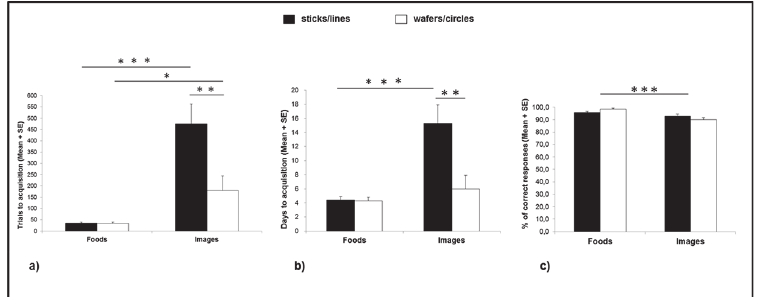
Fig 3. Monkeys ’ performance in Experiment 1. Monkeys ’ performance in the Food and Image conditions as a function of stimulus shape (sticks/lines and wafers/circles) was reported considering: (a) the number of trials to achieve the learning criterion (mean ± SE); (b) the number of days to achieve the learning criterion (mean ± SE); and (c) the percentage of correct responses in the last three training sessions (mean ± SE). * p < . 05; ** p < . 01; *** p < .